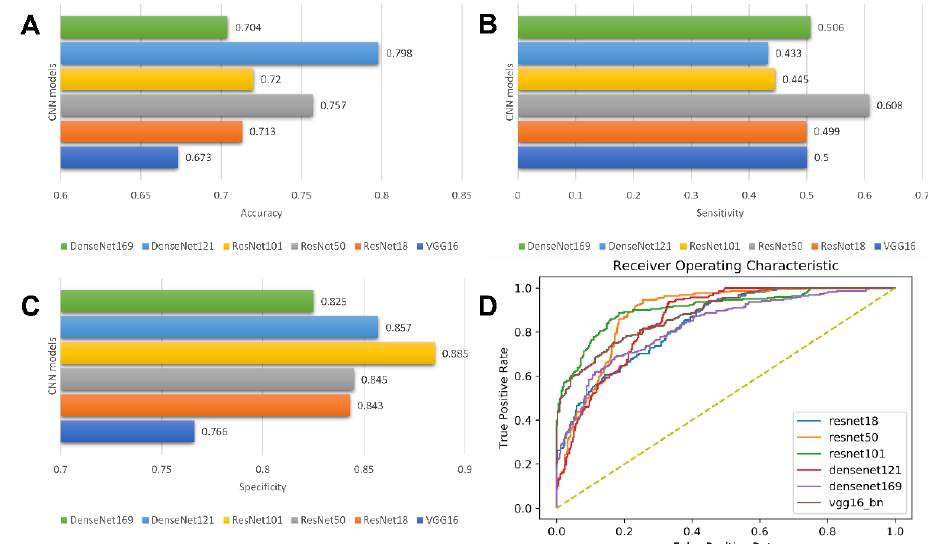
Figure 5. Model performance of CNN models. Bar charts of accuracy ( A ), sensitivity ( B ), and specificity ( C ); Receiver operating characteristic (ROC) curves of CNN models ( D ).